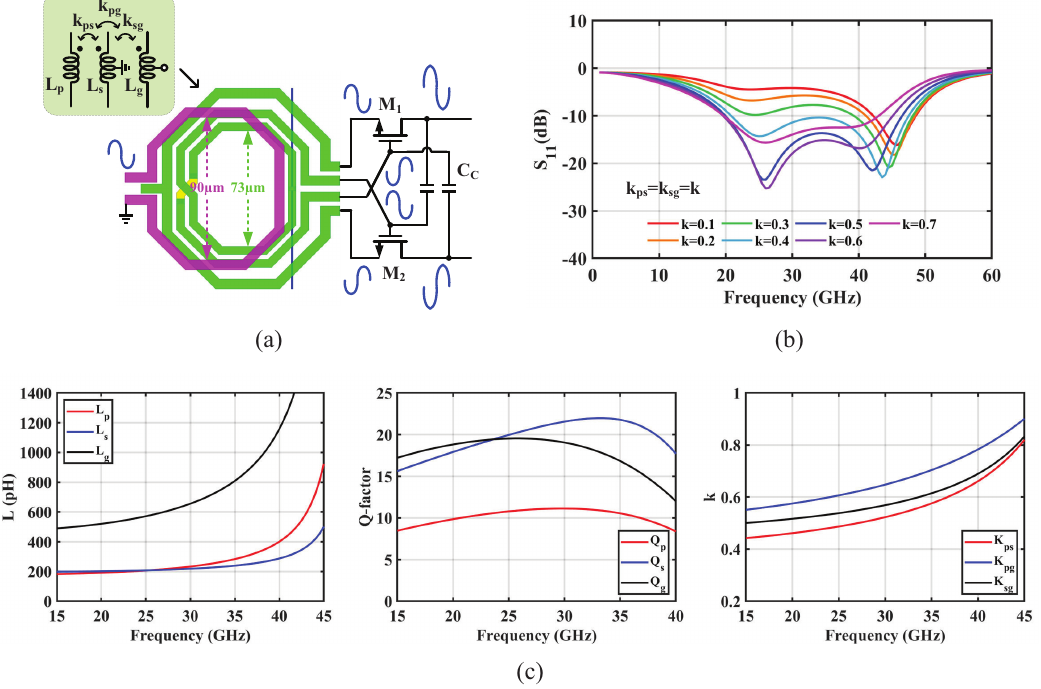
Figure 3. ( a ) 3D view of the transformer-based triple-coupled network. ( b ) input return loss with variety of the coupling coefficient k ps and k sg . ( c ) simulated results of the transformer-based triple- coupled